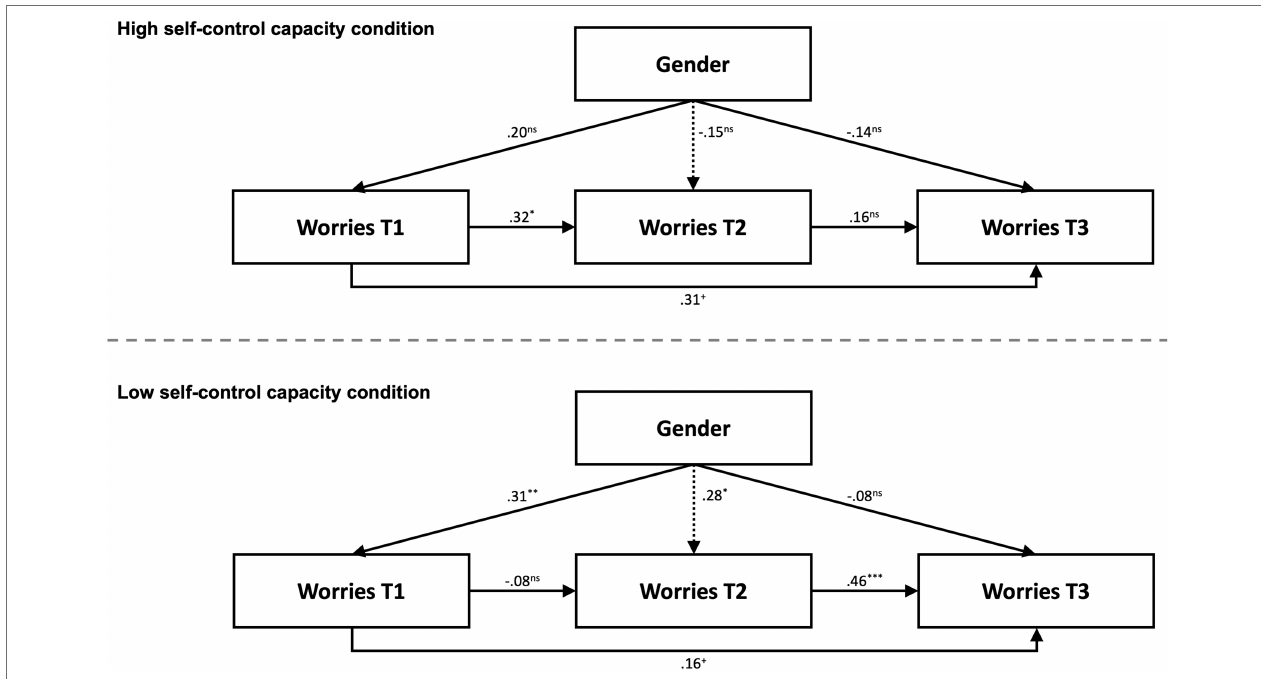
FIGURE 1 | Multiple-group autoregressive path model including gender as a covariate. Top: High self-control capacity condition. Bottom: Low self-control capacity condition. Coding of gender: 0 = male, 1 = female. T1/T2/T3 = first/second/third measurement times. Presented are standardized path coefficients. Dotted lines differ significantly between the two conditions. N = 102. *** p < 0.001, ** p < 0.01, * p < 0.05, + p < 0.10, ns = nonsignificant.